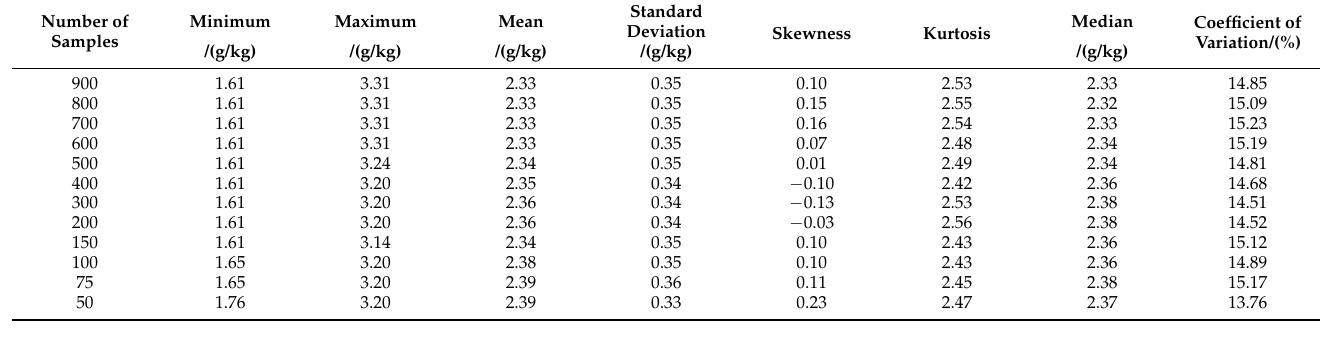
Table 2. Descriptive statistics of SOM content after logarithmic transformation.